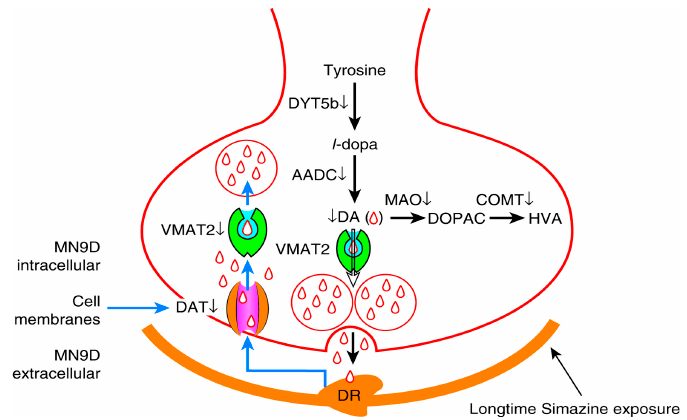
Figure 8. Dopaminergic neuron cell metabolism pathway. DYT5b and AADC participate in the